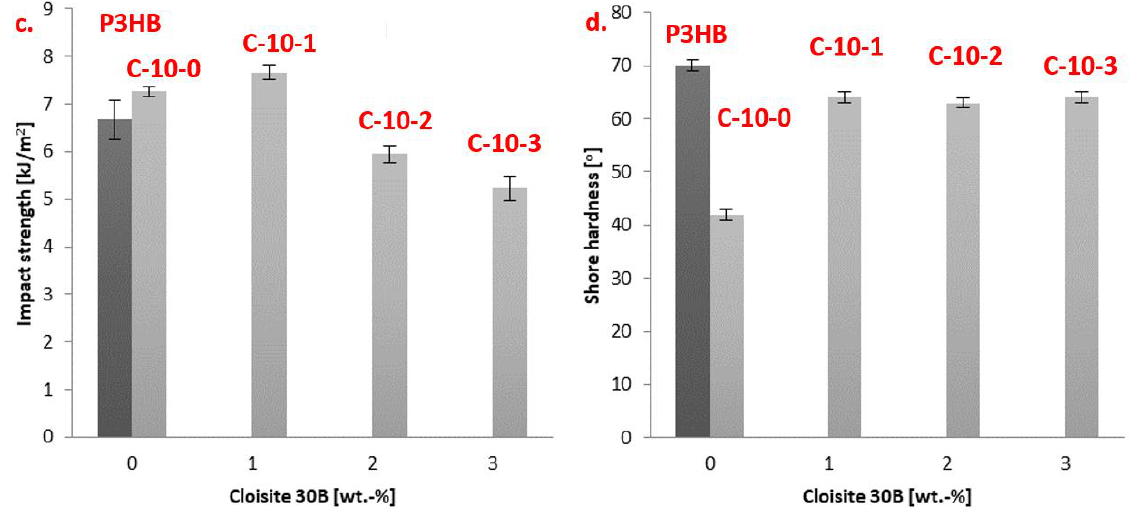
Figure 4. Effect of Cloisite ® 30B contents on the tensile strength ( a ), strain at break ( b ), impact strength ( c ) and Shore hardness ( d ) of P3HB and its nanobiocomposites with 10 wt.% of polyurethane (PU400) and 1, 2, and 3 wt.% of Cloisite ® 30B (designated as C-10-1, C-10-2, and C-10-3, respectively).